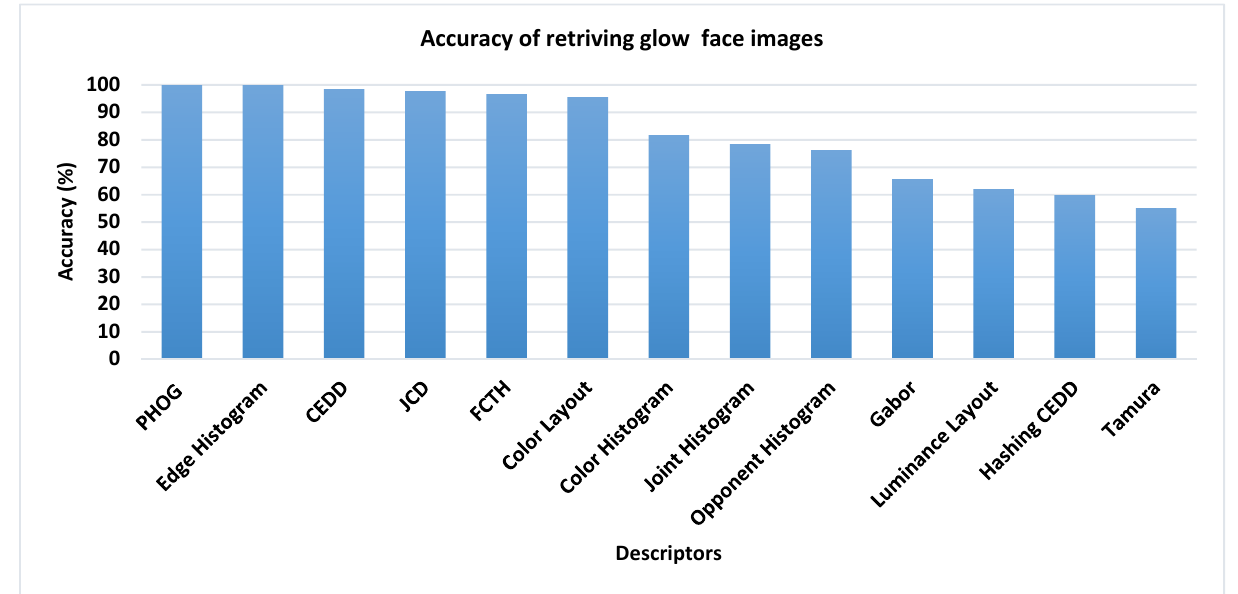
Figure 19. Average accuracy of retrieving glow-affected face images.